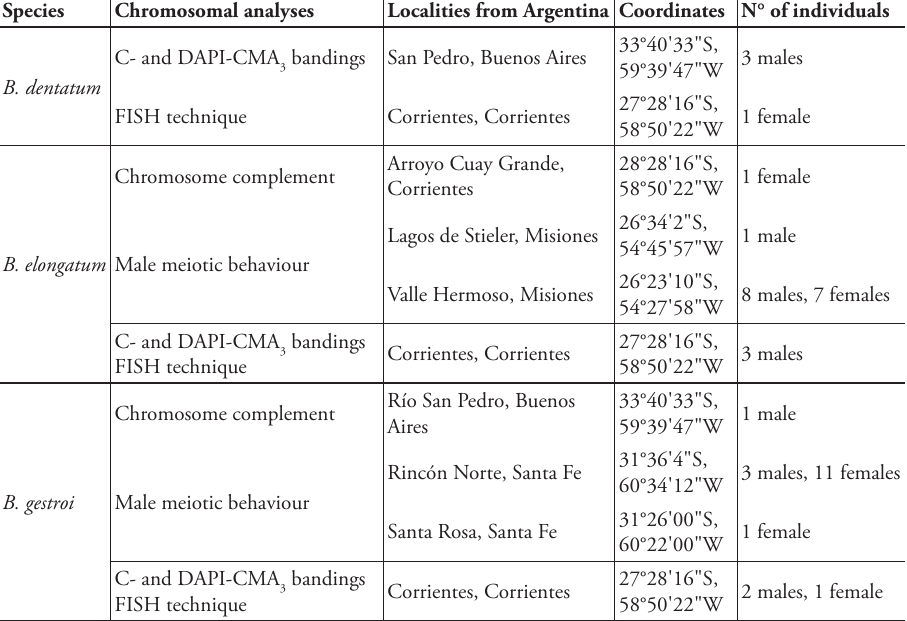
Table 2. Species, provenience, geographical coordinates, and number of adults’ collected and examined of Belostoma for chromosomal analyses discriminated by